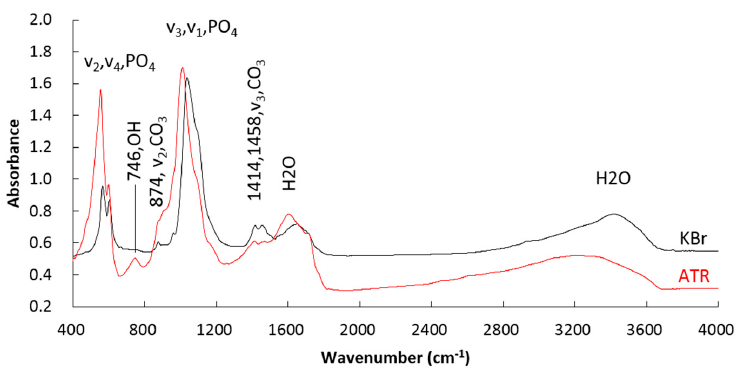
Figure 5. FTIR spectra of HAP in bones of Cololabis saira .